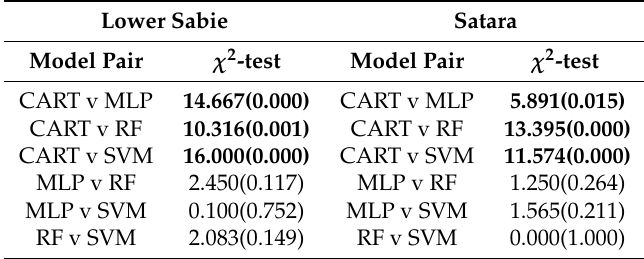
Table 8. McNemar’s chi-squared test ( χ 2 ) of marginal homogeneity between model pairs. Values in parenthesis represent p-value. Model pairs that show statistically significant difference ( p ≤ 0.05) in error rate are in bold. CART = Classification and Regression Trees, MLP = Multilayer Perceptron, RF = Random Forest, SVM = Support Vector